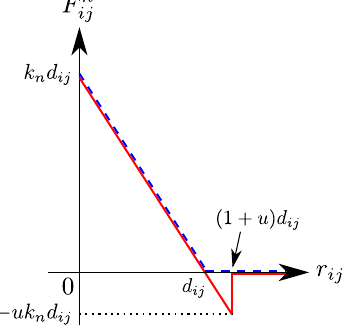
Figure 1. A schematic picture of the elastic part of the inter- particle force in the normal direction. The solid (dashed) line shows the case when there exists (does not exist) a bond between particles.